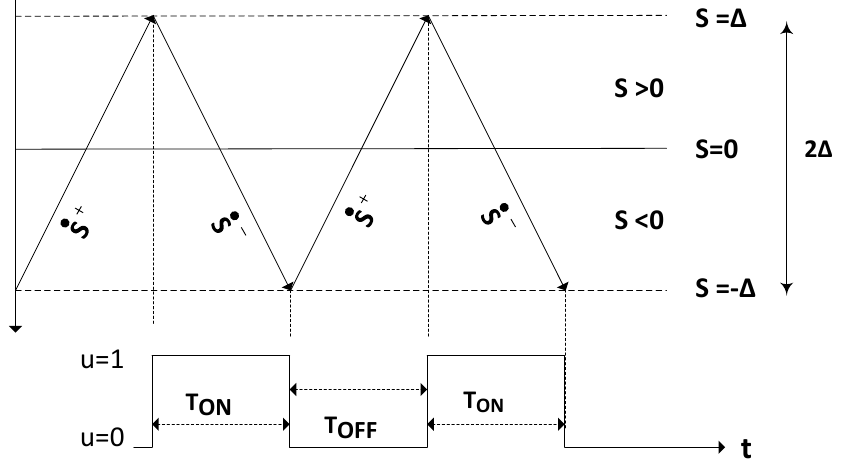
Figure 2. Hysteresis-modulated sliding